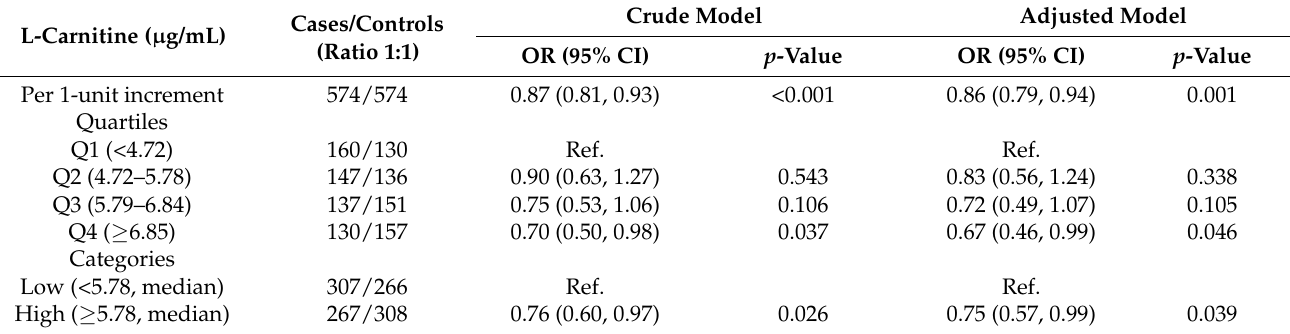
Table 3. The association of L ‐ carnitine with digestive system and non ‐ digestive system cancer risk. L ‐ Carnitine